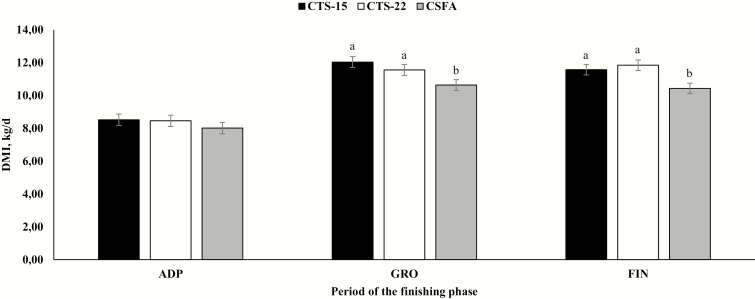
Mean DMI of Bos indicus beef animals receiving diets containing either 15% (CTS-15; n = 4) or 22% (CTS-22; n = 4) of cottonseed byproducts or calcium salts of fatty acids of cottonseed oil (CSFA; n = 4). A treatment × period was observed (P < 0.0001). Within periods, different letters denote differences (P ≤ 0.05).